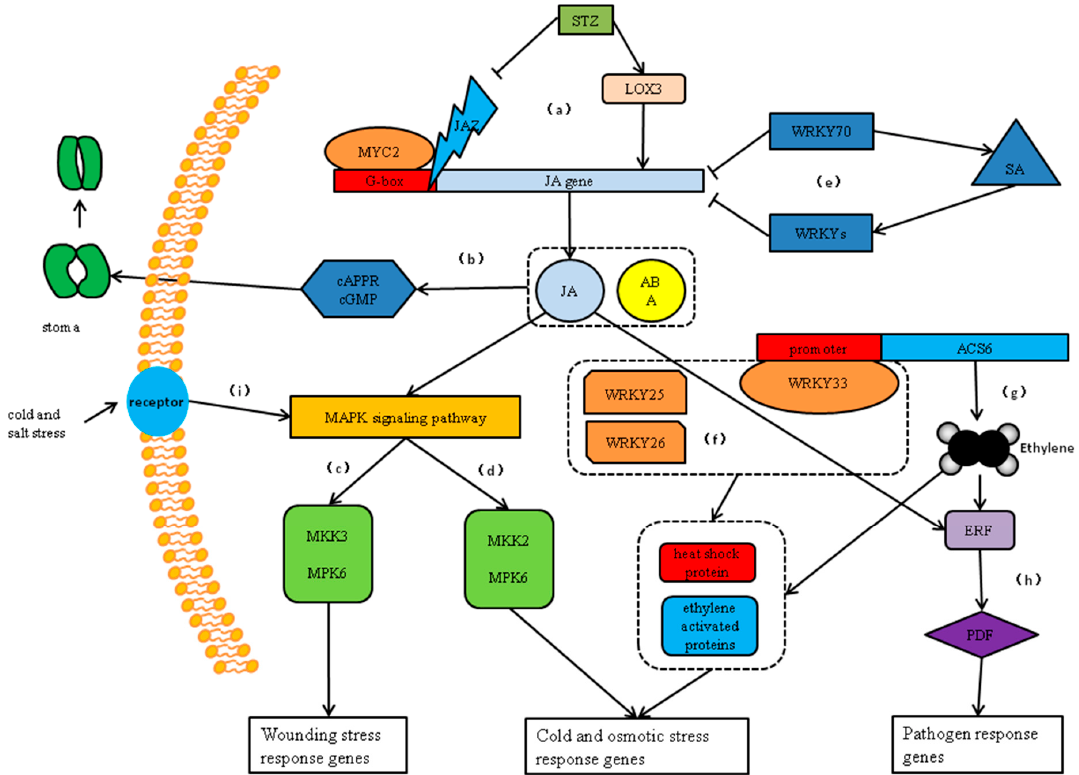
Figure 5. The stress signal path model of WRKY participation. ( a ) MYC2 is a major positive regulator of JA gene expression and is capable of binding to the G-box region upstream of the JA gene to increase gene expression levels. JAZ can suppress the combination of MYC2 and G-box area, and salt tolerance zinc finger (STZ) is involved in the early signaling response of JA and regulates the expression of the JA synthetic gene LOX3 . ( b ) The JA/ABA signaling pathway regulates the second messenger cAPPR and cGMP to close stomata. ( c ) The mitogen-activated protein kinase (MAPK) cascade, MAPK kinase 3 (MKK3)-MAPK 6 (MPK6), is activated by JA in Arabidopsis and is capable of inducing downstream wounding stress response genes. ( d ) MPK6 activation by MEKK1 is mediated by MKK2. MKK2–MPK6 cascades mediate cold and salt stress tolerance in plants. ( e ) WRKY70 can inhibit the expression of the JA gene and activate the SA signaling pathway to induce more WRKY transcription factors to inhibit JA. ( f ) WRKY25, WRKY26, and WRKY33 transcription factors interact to regulate cooperation between ethylene-activated protein- and heat shock protein-related signaling pathways. ( g ) ACS6 is a synthetic precursor of ethylene, and WRKY33 binds directly to the promoters of ACS2 and ACS6 to promote gene expression. ( h ) ERF can be activated by ethylene and act on PDF (plant defensin) to activate downstream pathogen response genes, which can also be regulated by JA. ( i ) When the receptor receives signals of cold or osmotic stress, it will stimulate the MAPK signal pathway and thus improve plant